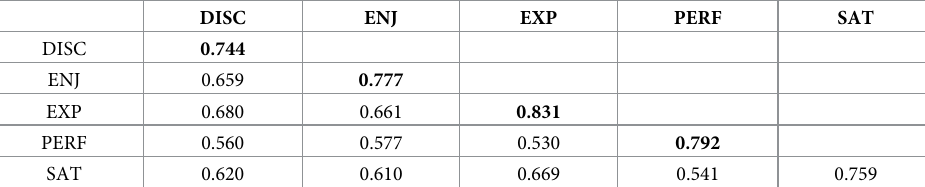
Table 3. Fornell-larcker criterion for discriminant validity